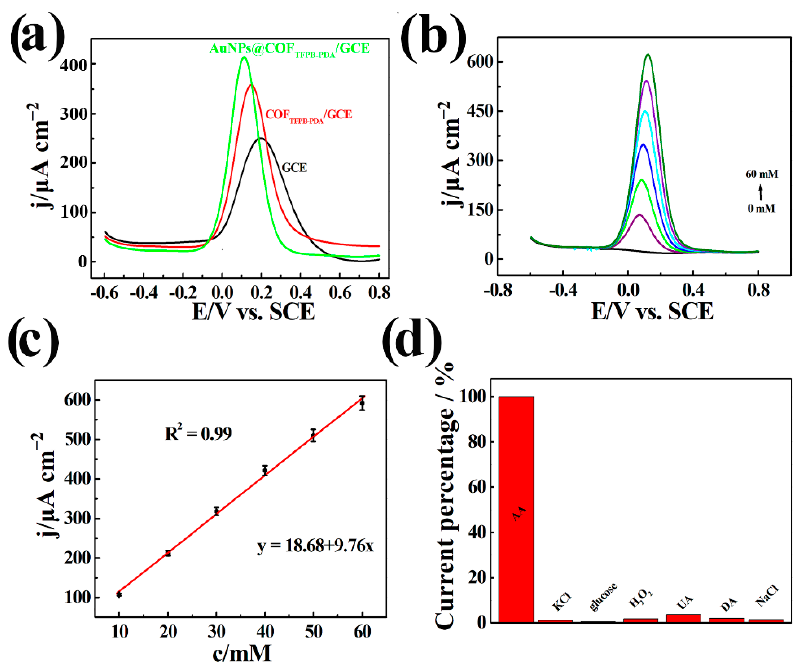
Figure 4. ( a ) DPV of GCE, COF TFPB-NBPDA /GCE and AuNPs@COF TFPB-NBPDA /GCE in 0.2 M phosphate buffered solution (pH = 6.5) with 30 mM AA; ( b ) DPV of AuNPs@COF TFPB-NBPDA /GCE AA in 0.2 M phosphate buffered solution (pH = 6.5) with different concentration of AA; ( c ) The corresponding linear relationship between peak current density and the concentration of AA; ( d )The diagram